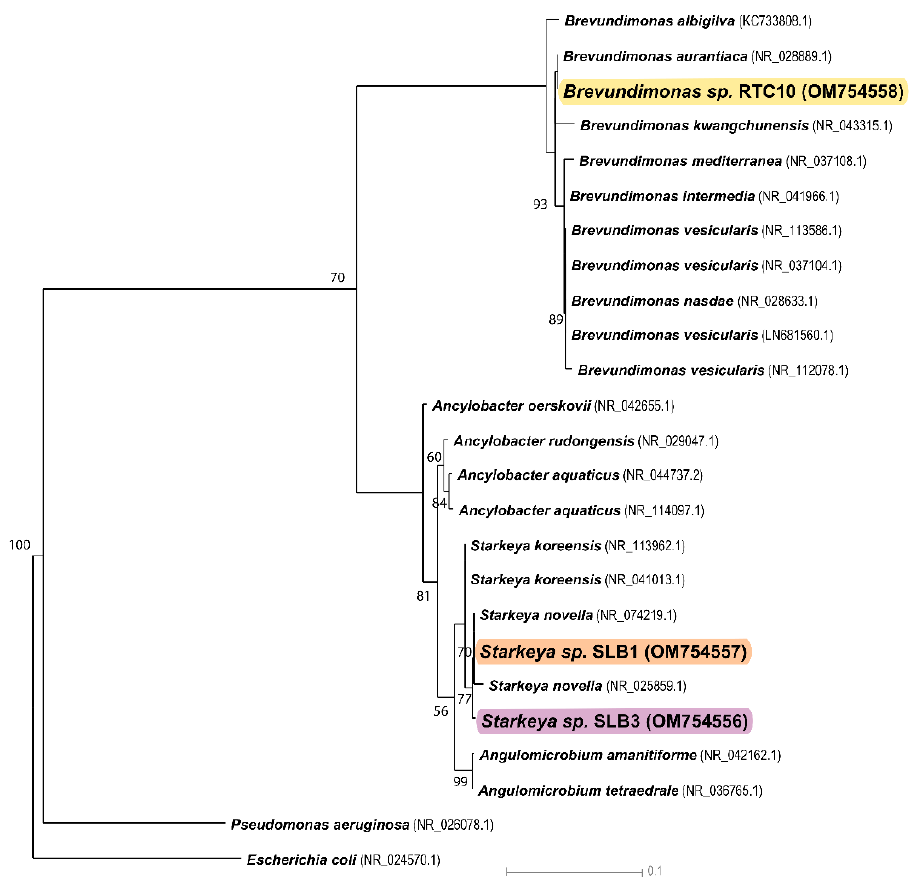
Figure 2. Phylogenetic tree of SLB1, SLB3, and RTC10 strains (highlighted by different colors in figure capture) and their nearest clustering neighbors. Evolutionary history was inferred using the Neighbor-Joining method. The maximum likelihood phylogenetic tree was performed in PhyML version 3.0 with the HKY85 nucleic acid substitution model and a bootstrap resampling value of 1000, using 25 sequences of 1336 nucleotides, on average, for each sequence. Bootstrap values were converted to percentages, and the branches corresponding to the partitions replicated in less than 50% of the bootstrap replicates were collapsed. One Escherichia coli sequence (NR_024570.1) and one Pseudomonas aeruginosa sequence (NR_026078.1) served as the